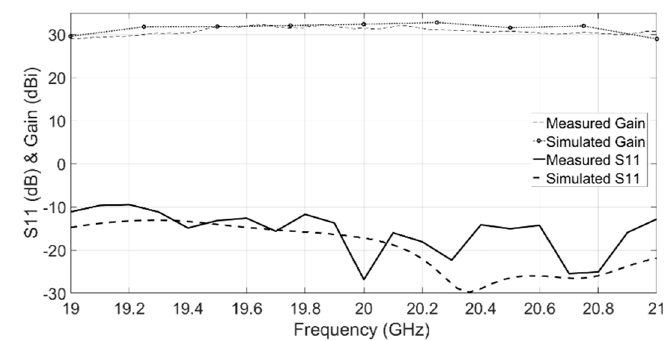
Figure 7. Measured and simulated antenna parameter: gain and matching. Simulations include the gaps shown in Figure 5.